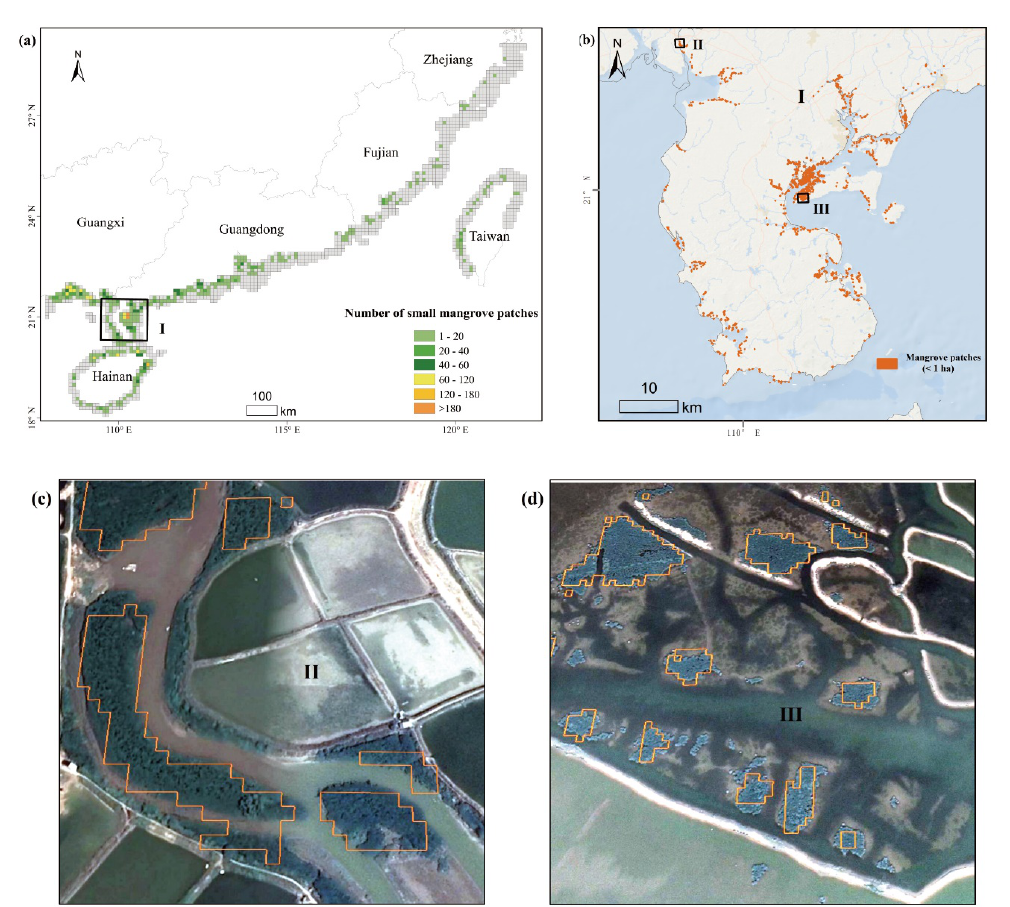
Figure 6. ( a ) The area percentage of mangrove patches with different size; ( b ) the frequency of mangrove patches with different size.